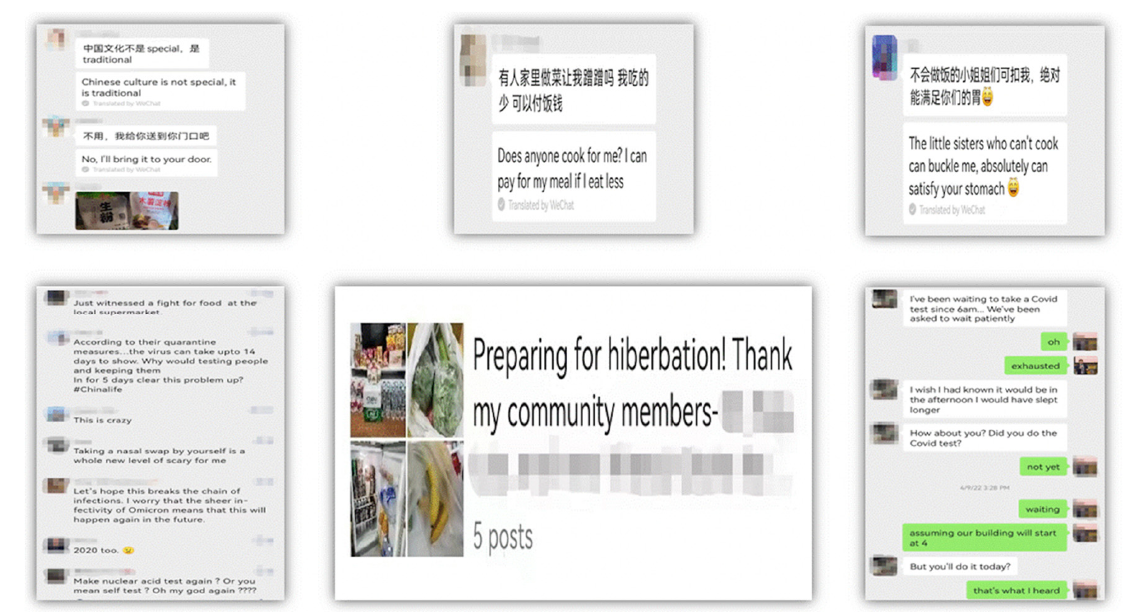
Figure 1. Example texts from WeChat group, moments, and personal communication.